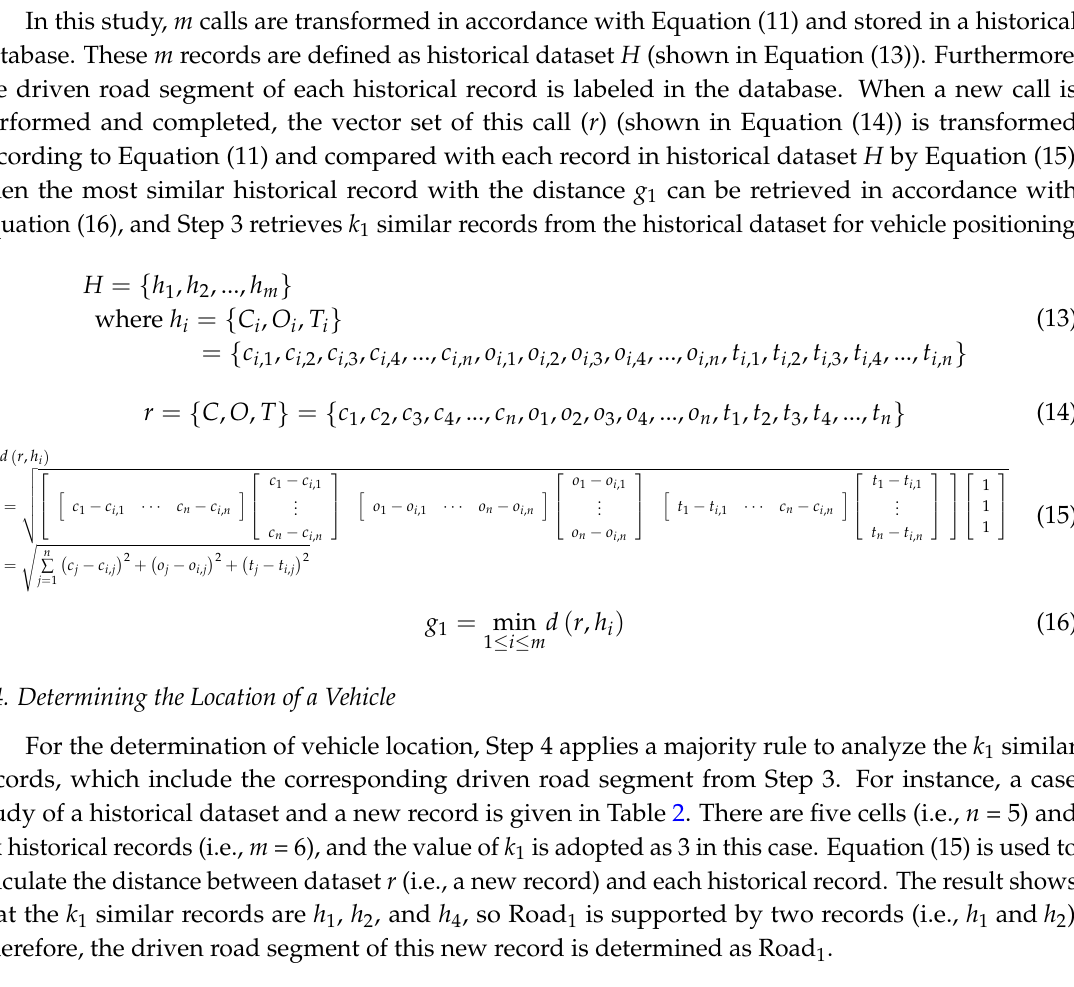
Table 2. A case study of historical dataset and a new